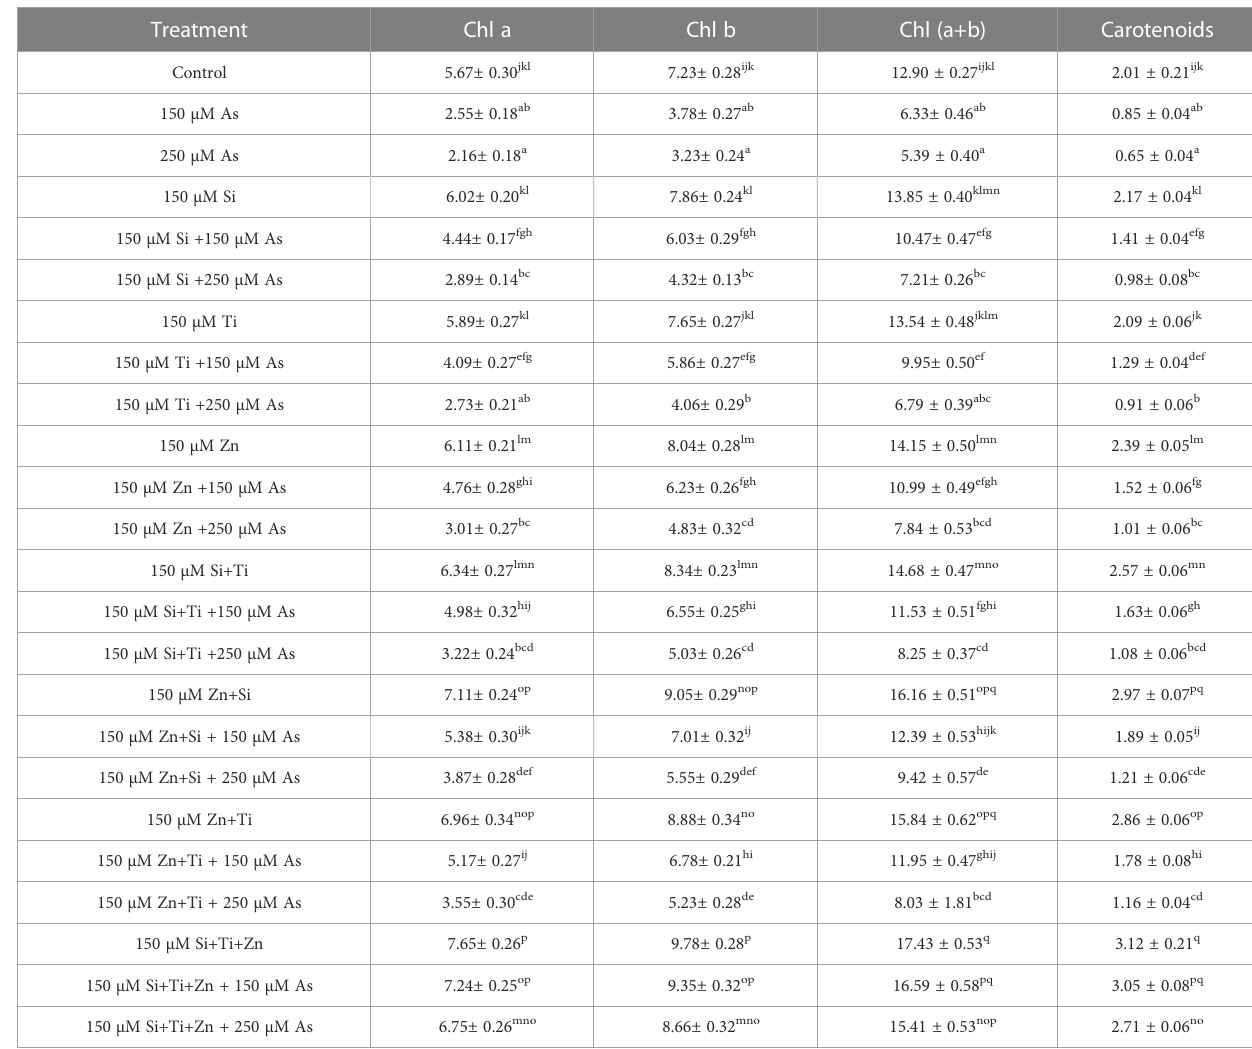
TABLE 3 The impact of NPs alone and in combination on the photosynthetic pigments (chlorophyll a, chlorophyll b, total chlorophyll and carotenoids) in one-year-old Pleioblastus pygmaeus .